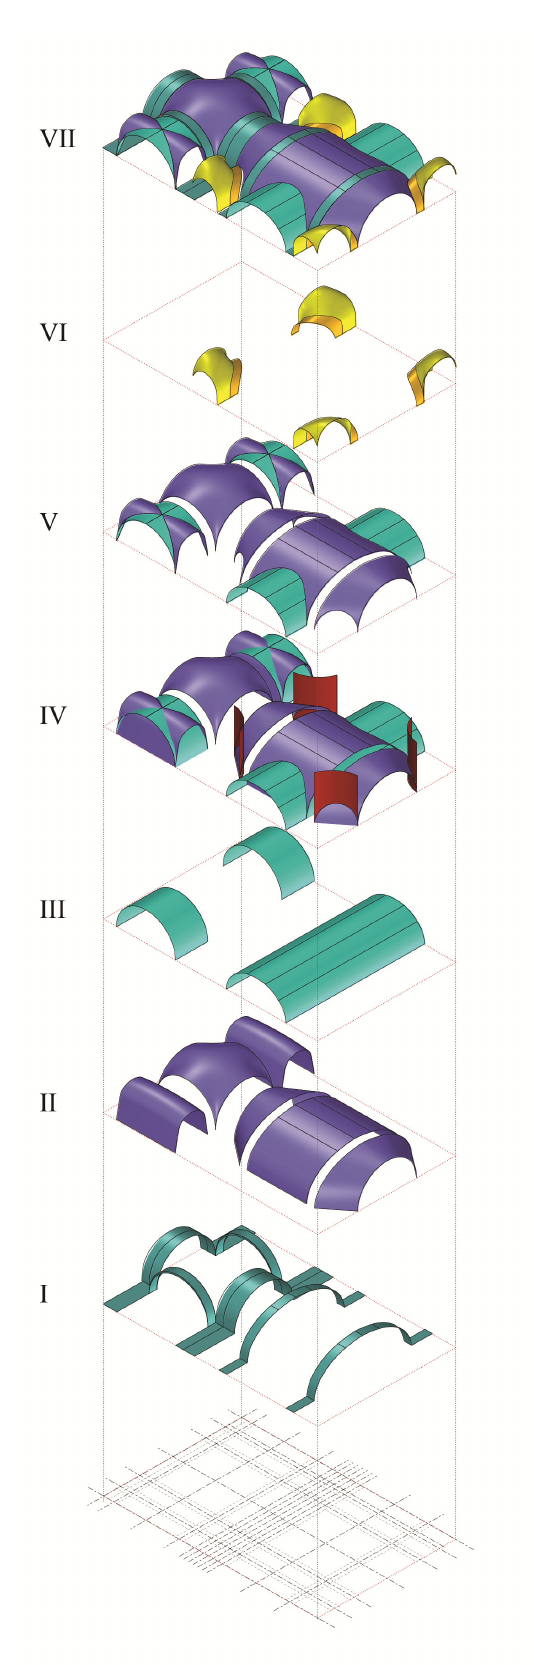
Figure 7 . Vault of Palazzo Mazzonis atrium: reconstructive model of the design geometries in axonometric exploded view. Modeling: F.